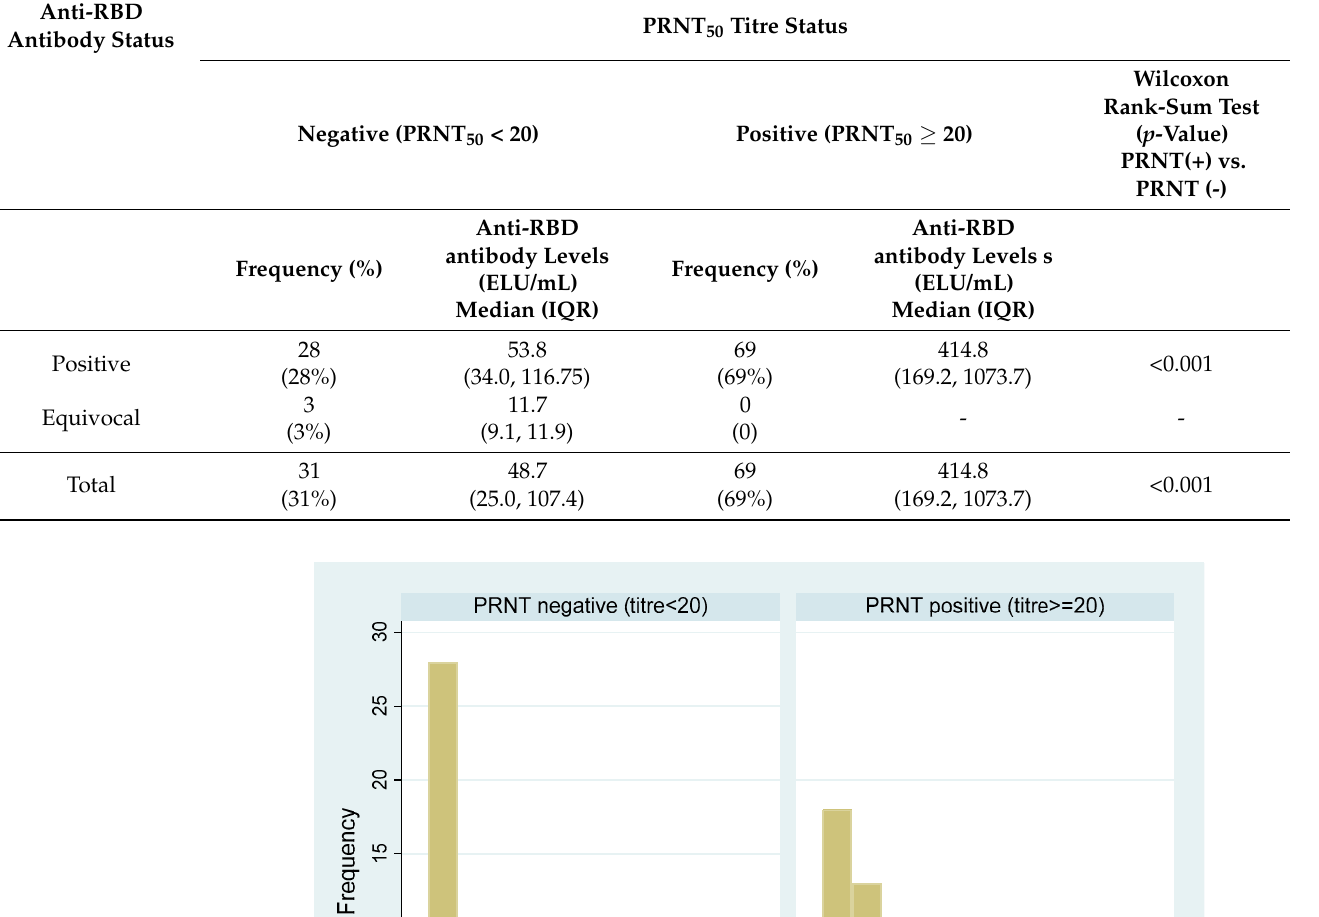
Table 2. Distribution of anti-RBD antibody levels by neutralizing antibody titre status.